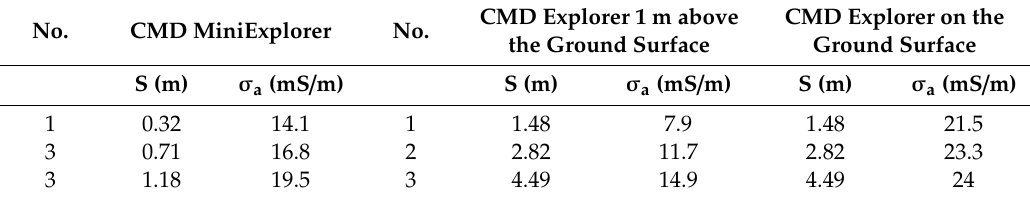
Table 4. Apparent synthetic conductivities for CMD MiniExplorer and CMD Explorer with HD